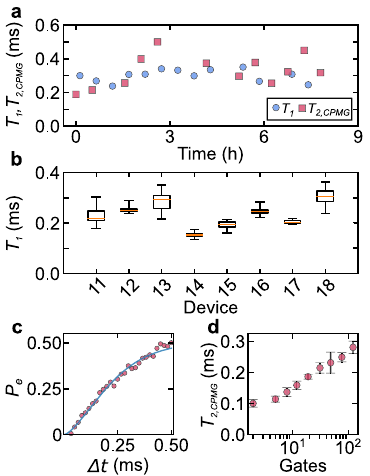
Fig. 2 Lifetime and decoherence measurements. a Lifetime ( T 1 ) and coherence time with dynamical decoupling ( T 2, CPMG ) of Device 18 over time. b Summary of T 1 time series measurements of all devices fabricated with a wet etch and piranha cleaning steps. Details about the speci fi c processing steps for each device are given in Supplementary Table 1 and “ Methods. ” The yellow line shows the median, while the box spans the middle two quartiles of the data. The whiskers show the extremal measurements. Data for Devices 13, 14, and 17 are the average of 19, 14, and 7 individual T 1 measurements, respectively, while the rest are the average of at least 32 measurements. Each device was measured over a period of hours to days, and Devices 11 and 13 include data from multiple dilution refrigerator cycles. c T 2,Echo measurement of Device 18, showing the excited state population P e as a function of delay time Δ t . Solid blue line shows a stretched exponential fi t to the data. The fi t gives T 2,Echo = 249 ± 4 μ s. d T 2,CPMG of Device 11 as a function of the number of gates in a CPMG pulse sequence. The error bars denote one standard deviation in the